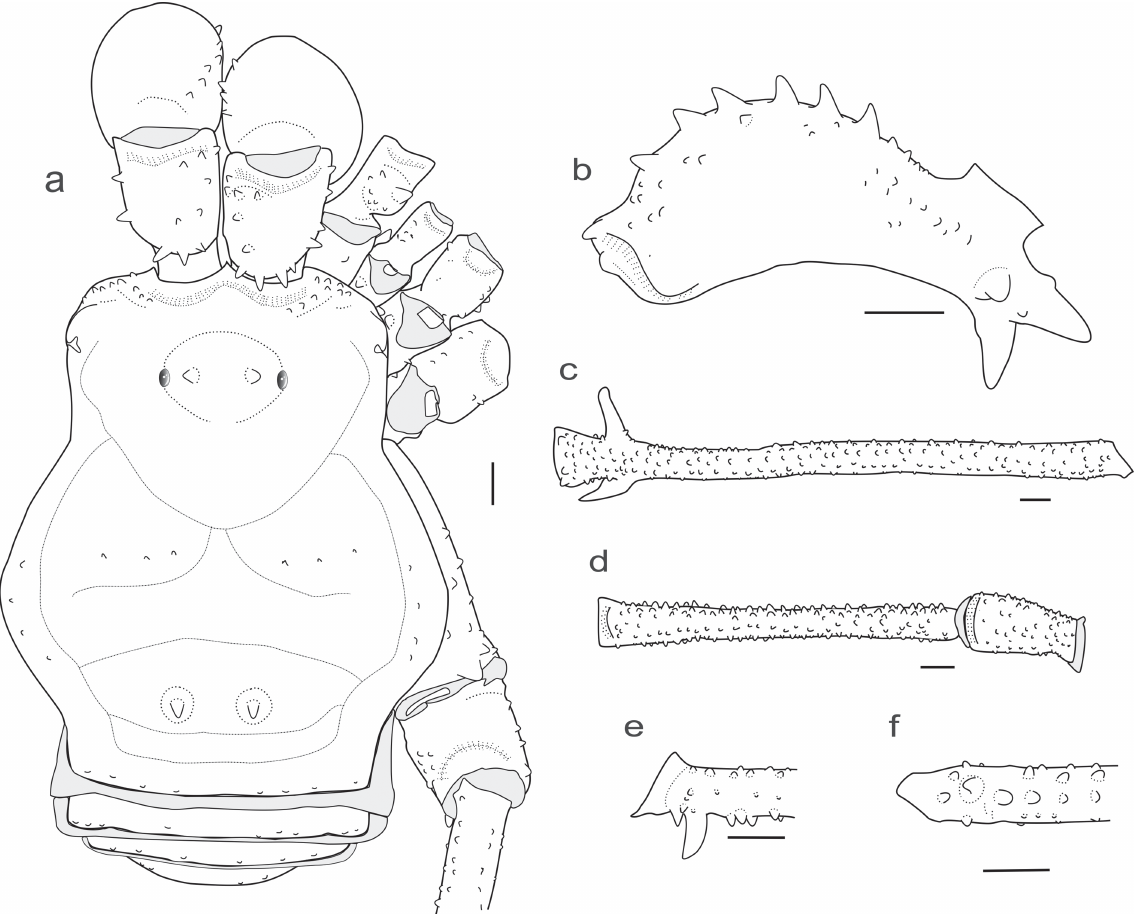
Fig. 5. Phalangodus briareos sp. nov., holotype, ♂ (MNRJ 2382). a . Habitus, dorsal view. b . Left pedipalpal femur, ectal view. c . Right femur IV, dorsal view. d . Right patella and tibia IV, dorsal view. e–f . Right femur II, proximal portion. e . Retrolateral view. f . Ventral view. Scale bars =